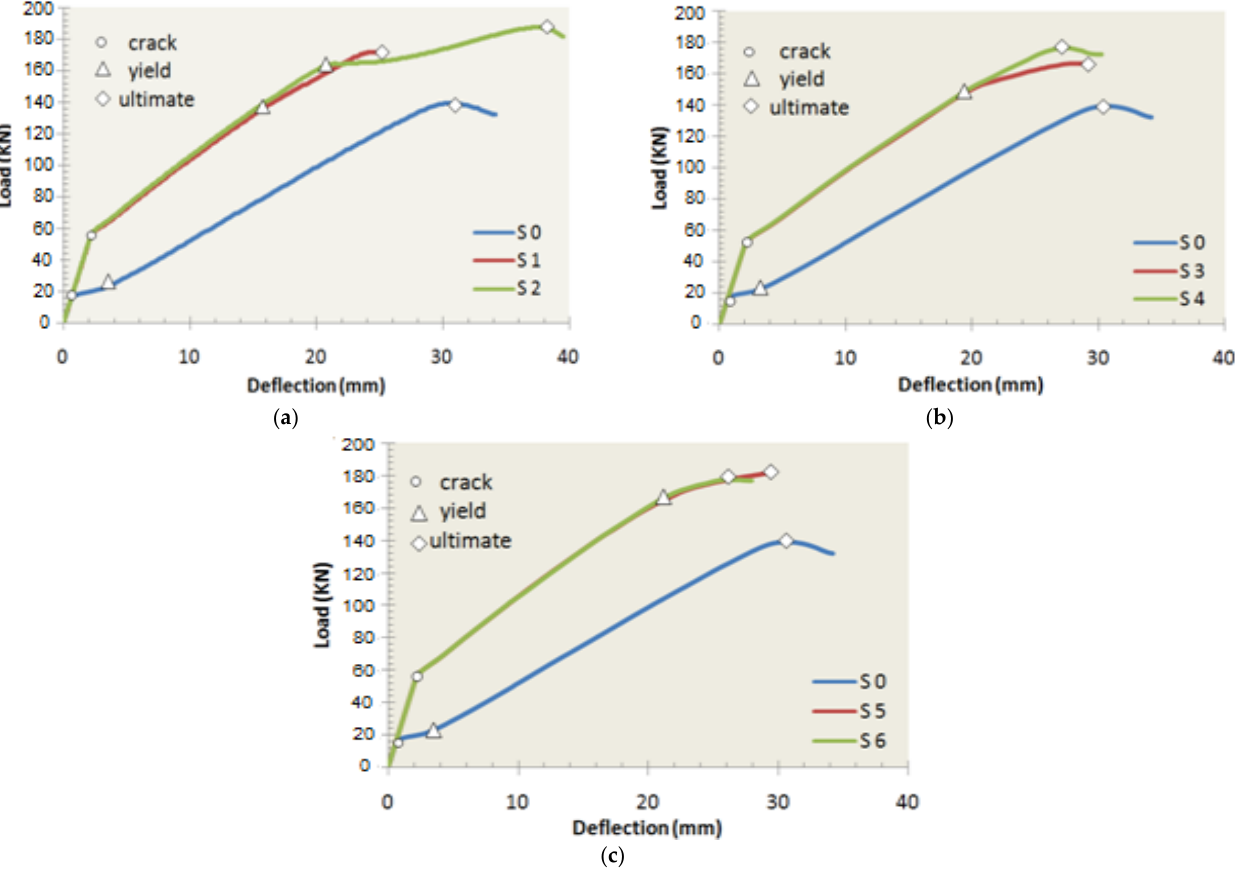
Figure 15. Load–displacement relation of all specimens: ( a ) straight-line tendons (S0 with S1 and S2); ( b ) V-shaped tendons (S0 with S3 and S4); ( c ) U-shaped tendons (S0 with S5 and